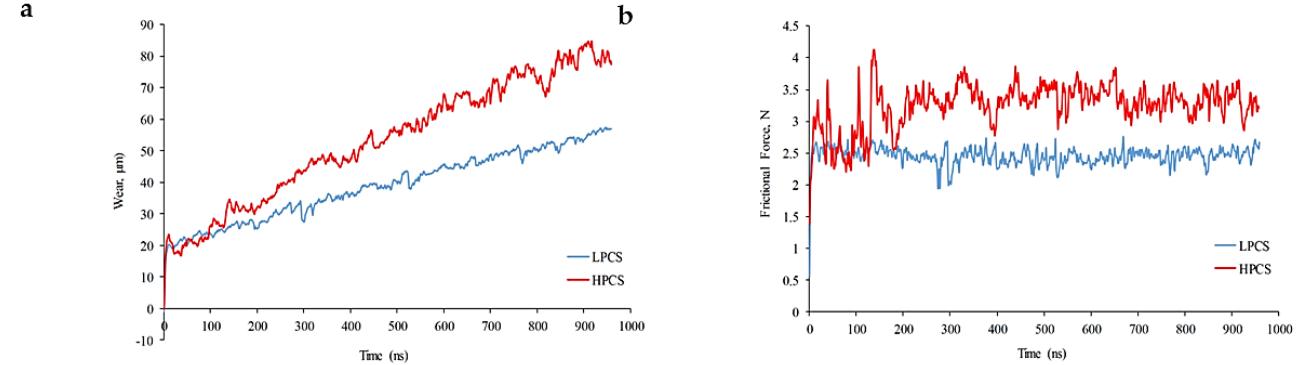
Figure 5. ( a ) Wear load; ( b ) frictional force of Al coatings using HPCS and LPCS. Figure 6 shows the variation of the friction coefficient of Al coating deposited using HPCS and LPCS as a function of time subjected to 2 N. The wear tests conducted on the HPCS and LPCS coatings demonstrated that the friction coefficient varied between 0.001 and 1.8 µ and between 0.3 and 1.4 µ for HPCS and LPCS, respectively, as seen in Figure 6. These results show that the LPCS coating has a smaller range of friction coefficient than the HPCS coating.